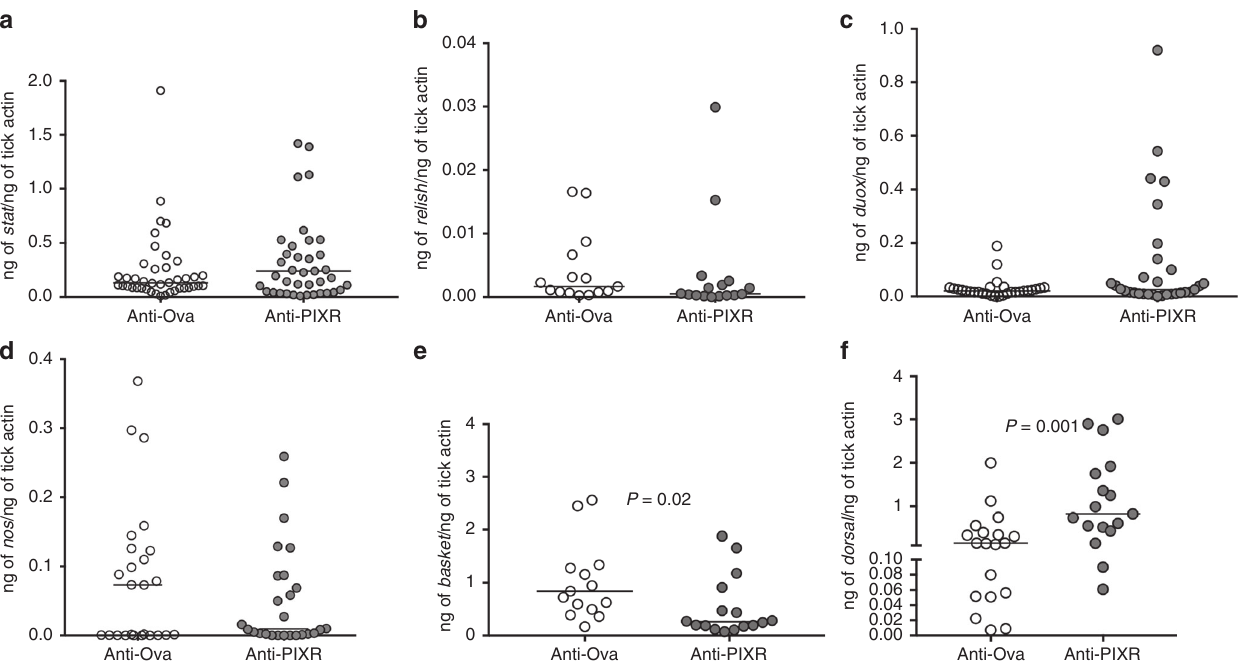
Fig. 6 PIXR abrogation and impact on tick immune response genes. qRT-PCR analysis of expression levels of: a stat ; b relish ; c duox ; d nos ; e basket ; and f dorsal in repleted larvae fed on rPIXR-immunized or ovalbumin-immunized B . burgdorferi -infected mice. Each data point represents a pool of two to three guts. Horizontal bars represent the median. Mean values signi fi cantly different in a non-parametric Mann – Whitney test ( P < 0.05)